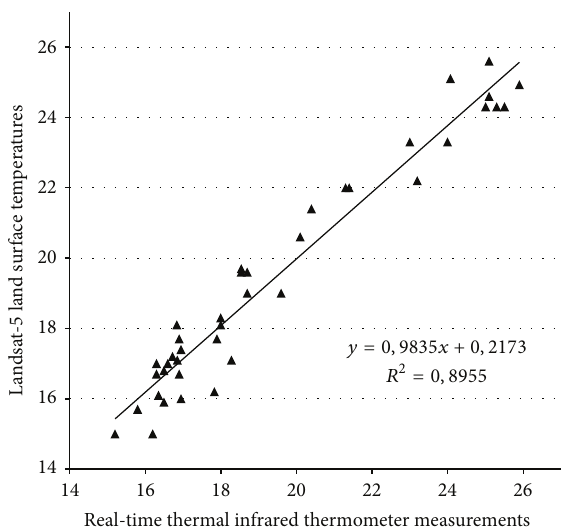
Figure 4: Relationships between real-time ( in situ ) thermal infrared thermometer measurements and land surface temperatures calcu- lated from Landsat-5 thermal infrared band (real-time measure- ments were collected on August 21, 2011 07:30–11:00 AM,